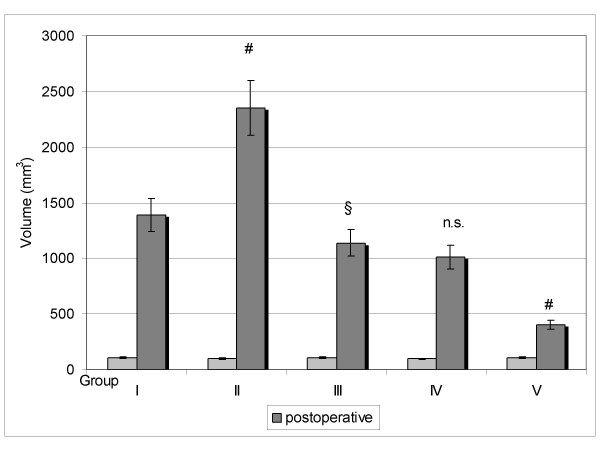
The mean tumor volumes + SEM of groups I to V (n = 30) 6 weeks after treatment; Group II, III, IV and V compared to group I (§: P = 0.036 ; #: P = 0.021 (Kruskall-Wallis) n.s.:not significant).